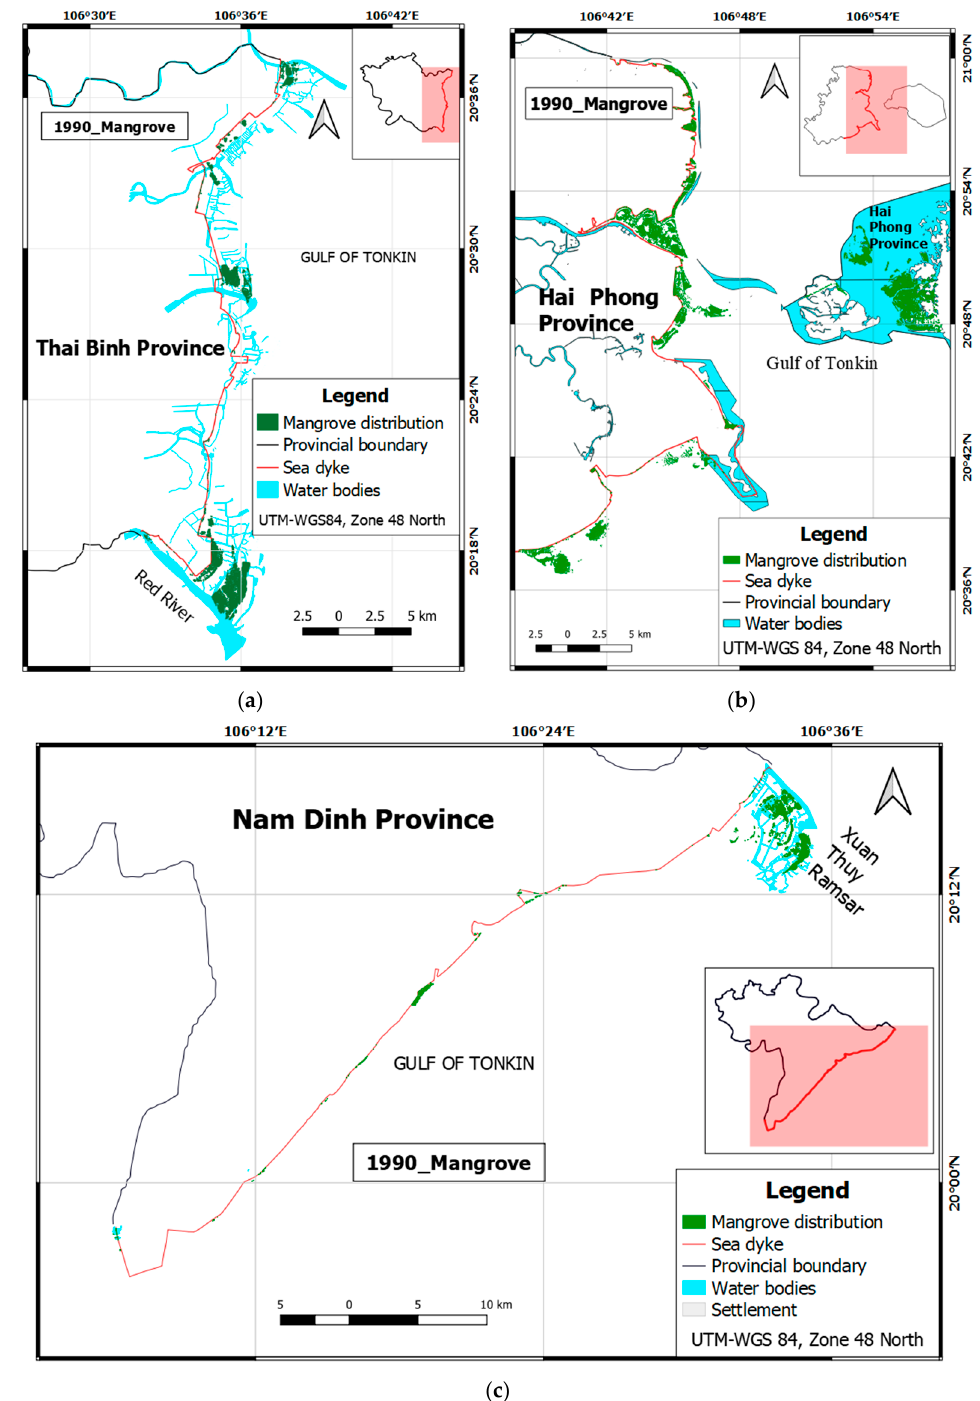
Figure 6. Mangrove maps in the three provinces in 1990 across the RRD, northern Vietnam: ( a ) Thai Binh; ( b ) Hai Phong; ( c ) Nam Dinh.